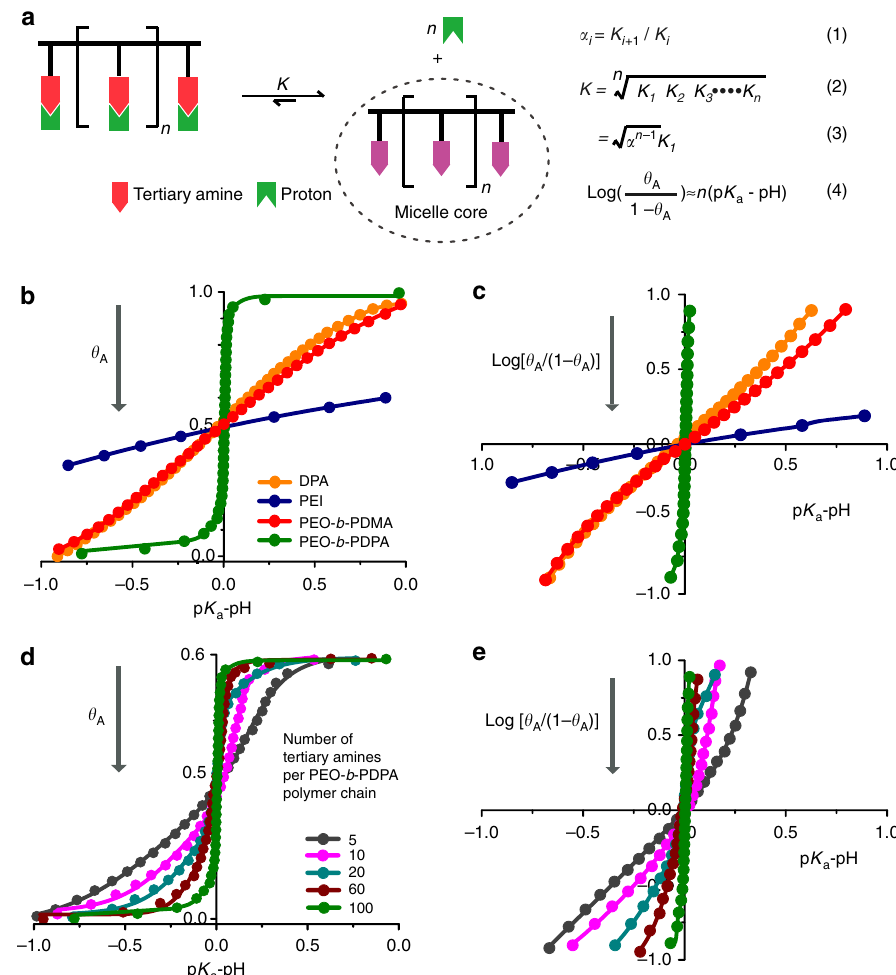
Figure 5 | Model construction to quantify the pH cooperativity. ( a ) Micelle-driven deprotonation model with key equations. These equations allow the theoretical-experimental correlation between the microscopic cooperative parameter a and macroscopically measurable p K a . ( b , c ) Cooperativity analysis based on Hill plot of small molecular base DPA, polymeric bases of PEI, PEO- b -PDMA and PEO- b -PDPA. DPA and PEO- b -PDMA showed non-pH cooperativity. PEI displayed negative pH cooperativity and PEO- b -PDPA showed strong positive cooperativity. ( d , e ) Cooperativity analysis of PEO- b -PDPA copolymers with different number of repeating units in the hydrophobic segment. Increase of hydrophobic chain length led to stronger positive cooperativity and sharper pH